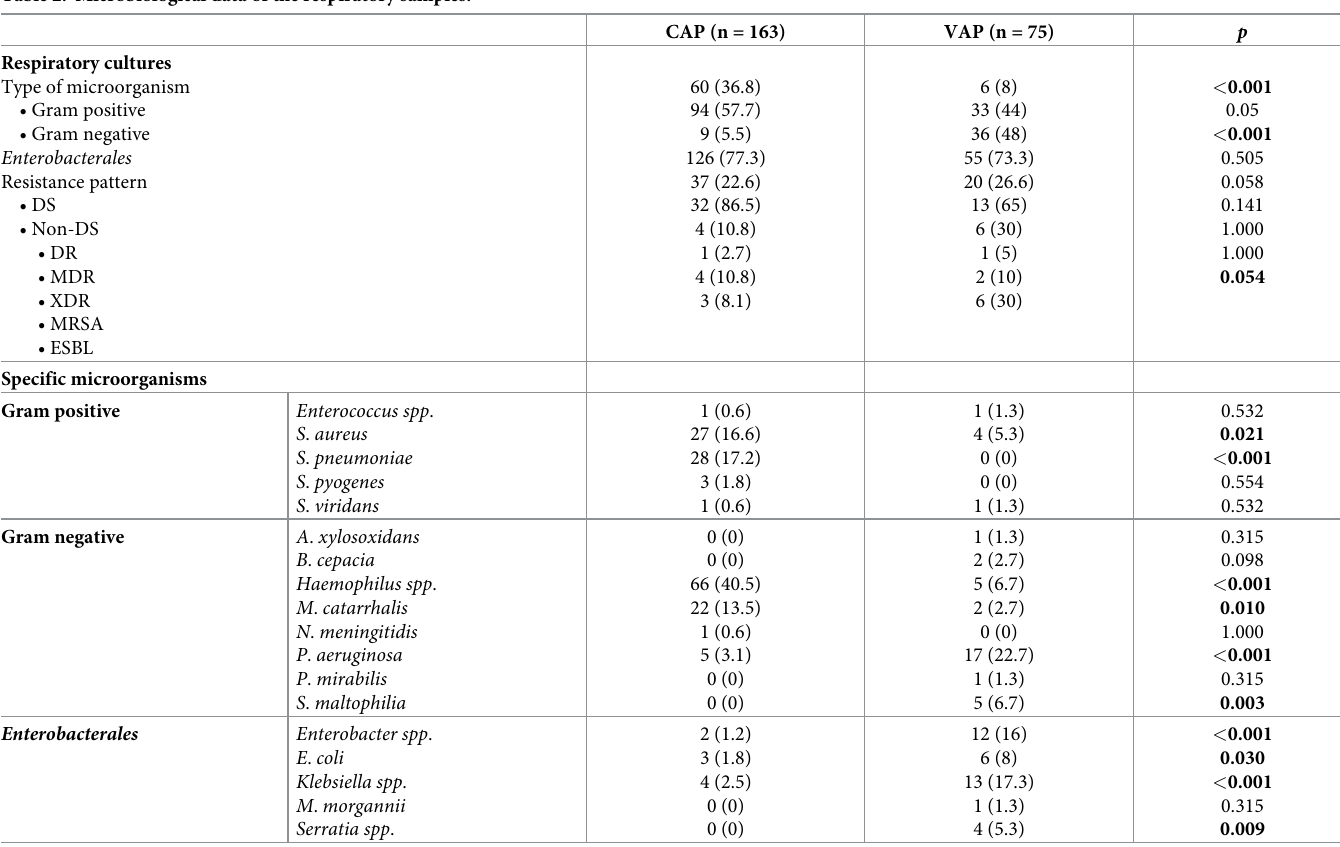
Table 2. Microbiological data of the respiratory samples.